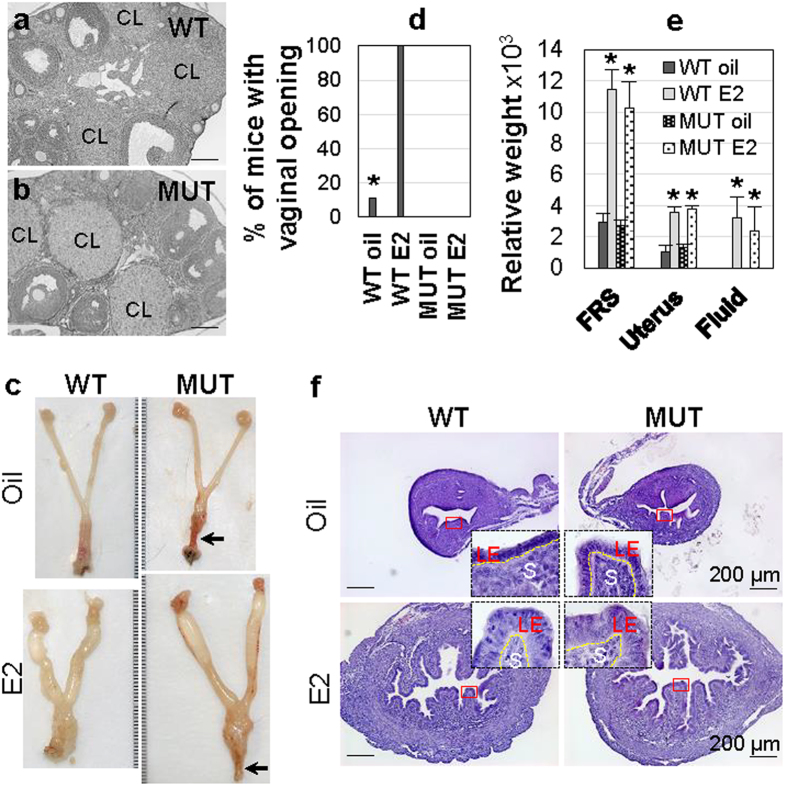
Ovary histology and uterine response to E2 treatment for 3 days.(a,b) Histology of 8-week old WT (a) and MUT (b) ovaries. CL, corpus luteum. (c) Representative images of 24- day old WT and MUT female reproductive system upon vehicle (oil) or E2 treatment. Black arrow, vaginal atresia. (d) Percentage of WT and MUT mice with vaginal opening upon oil or E2 treatment. (e) Relative weight of WT and MUT female reproductive system (FRS), uterus, and fluid upon oil or E2 treatment. Error bar, standard deviation; N = 5–9 (c–e); *P < 0.05 compared to vehicle control. (f) Representative WT and MUT uterine histology upon oil or E2 treatment. Insert in each panel, enlarged view of the red rectangle area; LE, uterine luminal epithelium; S, stroma; scale bar, 200 μm.